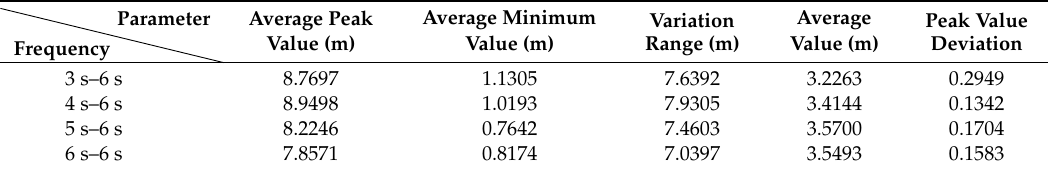
Table 3. Pressure values and statistical analysis after air inflow has been cut off for 6 s (round nozzle at the bottom of the pipe).